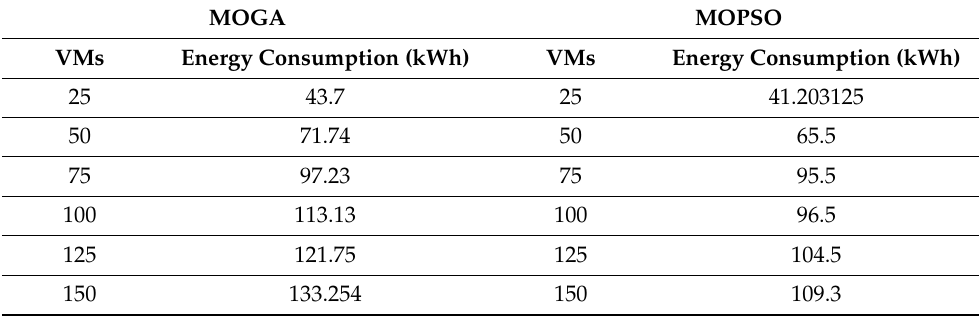
Table 4. Energy consumption evaluation for MOGA and